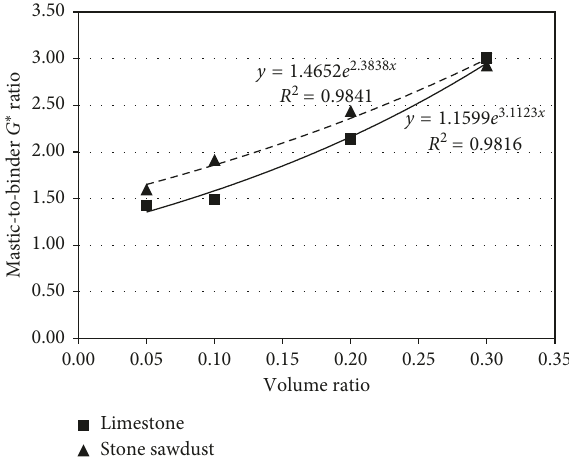
(cid:30) Figure 24: Mastic-to-binder modulus ratio versus volume ratio ( T 40 ° C and f 1 Hz). (cid:30) (cid:30)